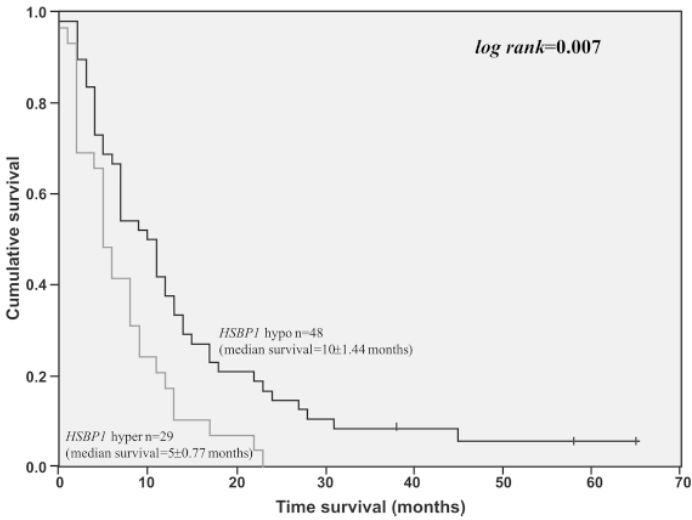
Figure 3. Overall survival time of GBM cases presenting HSPB1 high expression level (3-fold of cut-off value determined by ROC curve) (n = 29) compared to GBM cases presenting lower HSPB1 expression level (n = 48). Log-rank = 0.007 [54].